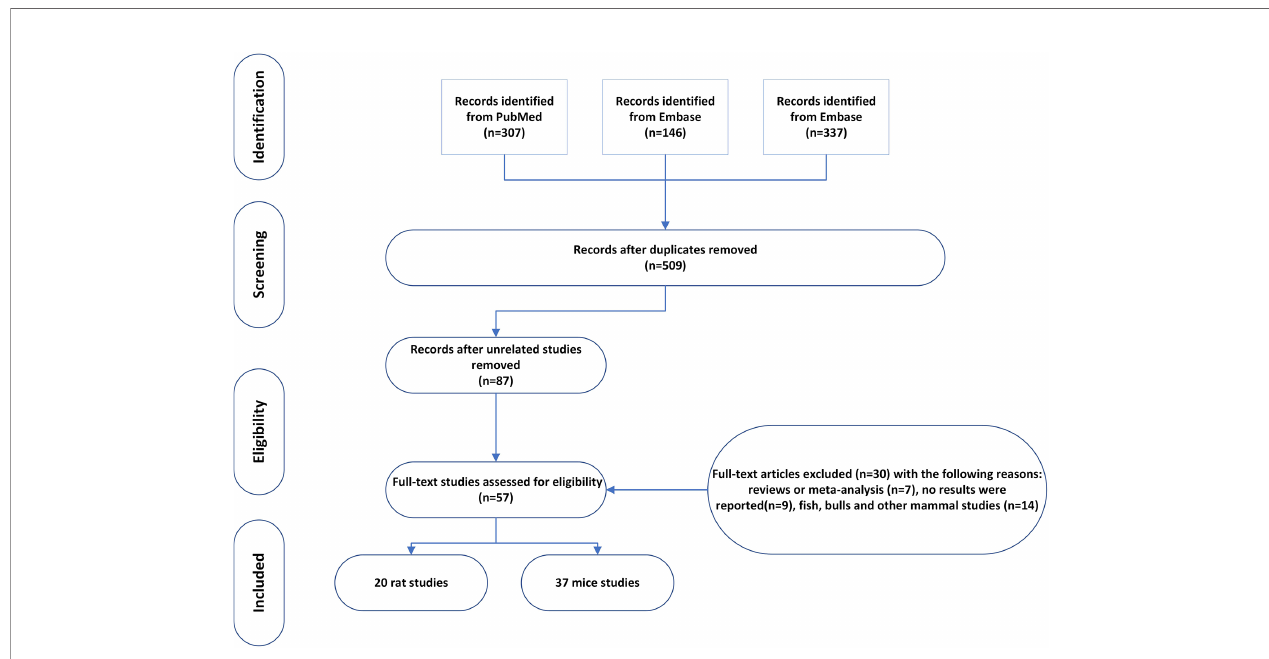
FIGURE 1 | Study Selection Flow Diagram.